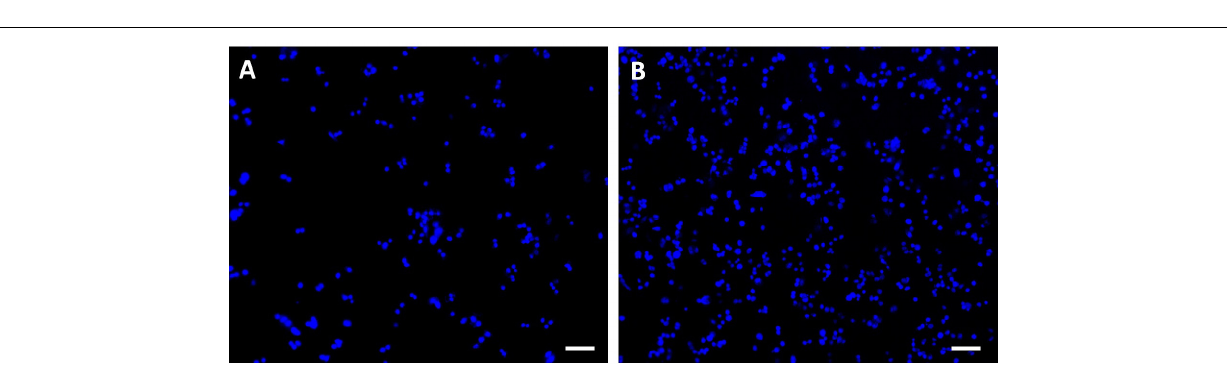
FIGURE 8 | Confocal microscope images of the breast cancer cells with DAPI-labeled nuclei attached on the (A) undeformed and (B) 35% deformed sample. Scale bars are 100 µ